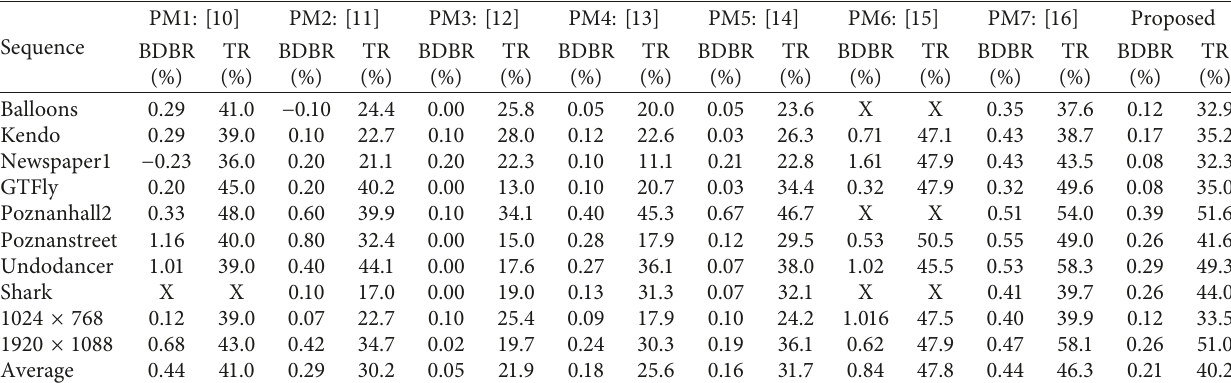
Table 6: Resulting experiences of the proposed size decision model in all intraconfiguration.